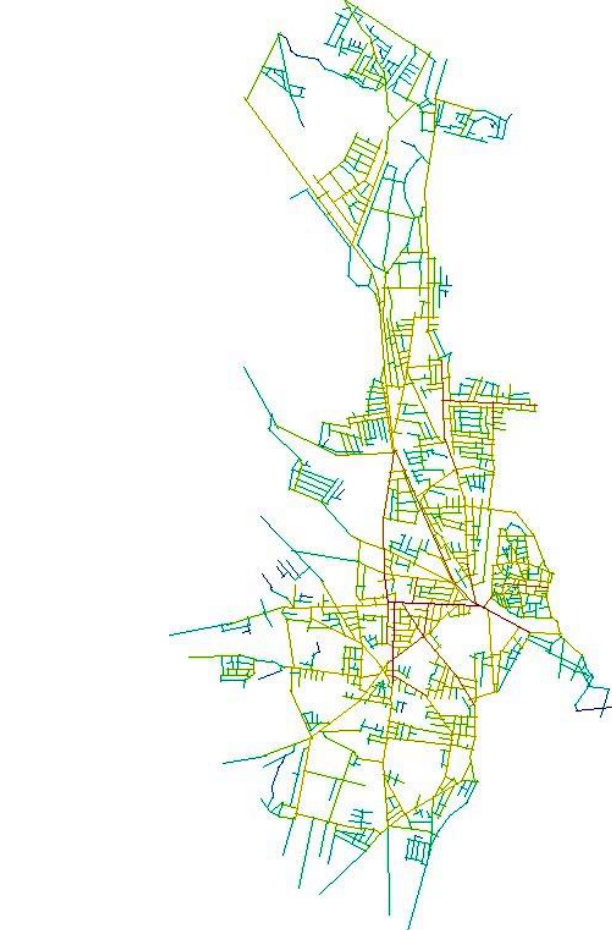
Figure 3. The axial map in the present condition and Rn values. Figure 4. Axial map at the present condition and R5